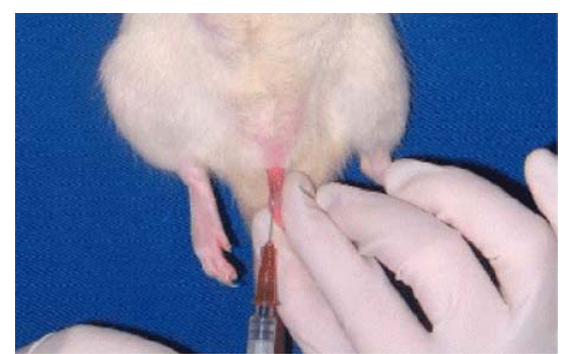
FIGURE 1 - Administration of a lloxan in the animal’s penial vein.